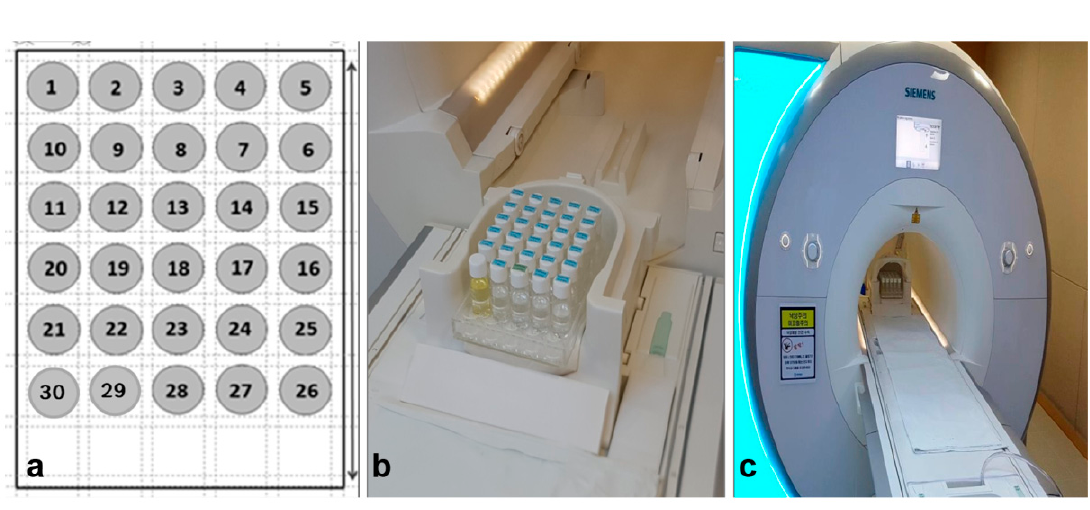
Table 2. MR phantom parameters.